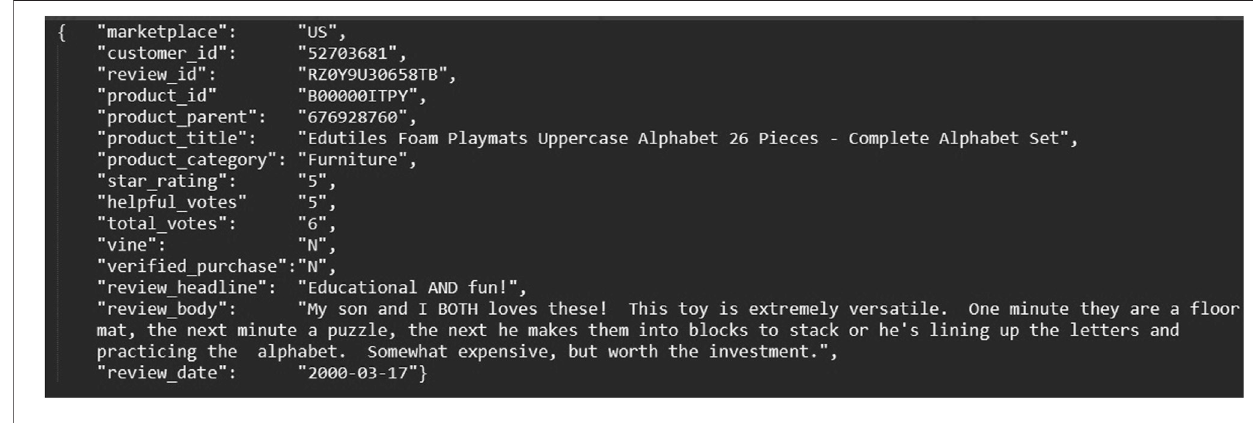
FIGURE 1 | Simple amazon raw data.